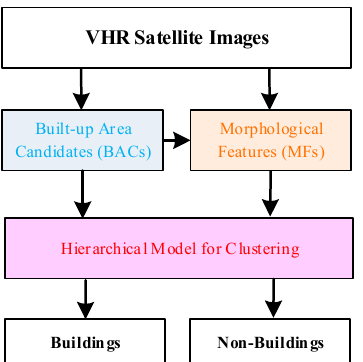
Figure 3. Three components in the gCRF_MBI (i.e., generalized Chinese restaurant franchise and morphological building index) method. Table 1. The glossary of acronyms used in the paper.